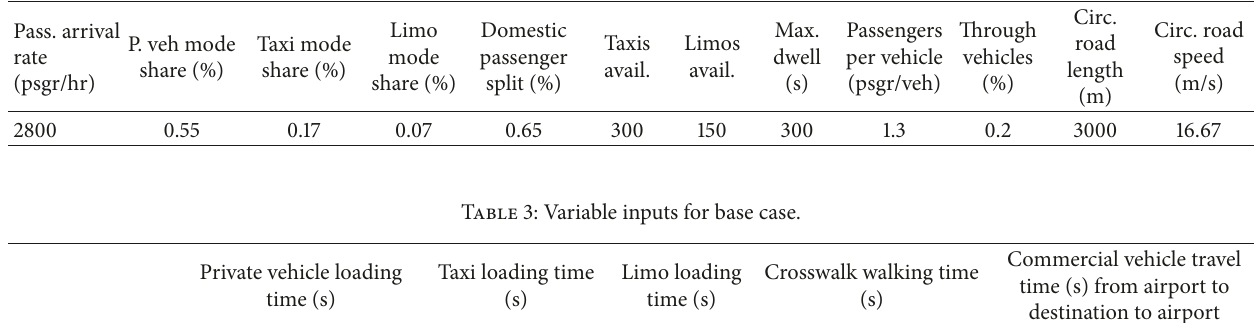
Table 2: Constant inputs for the base case.